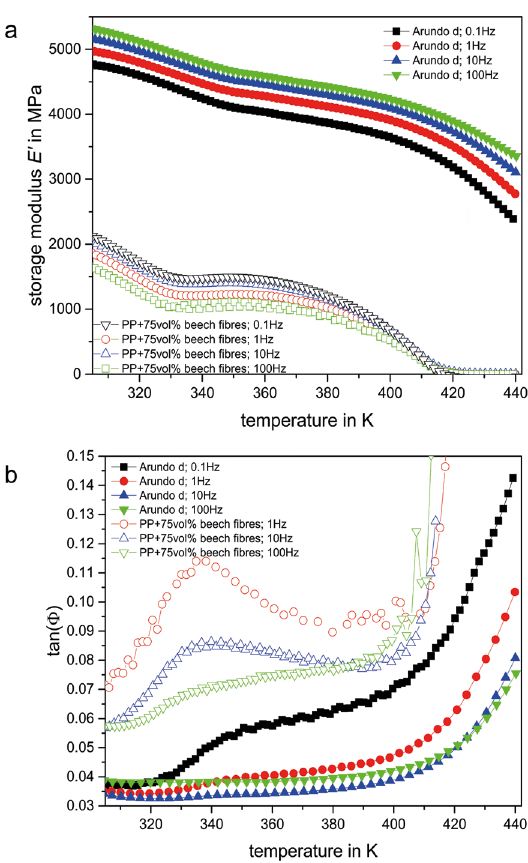
Figure 2. Temperature dependent storage modulus (a) and loss factor (b) of Arundo donax and PP-beech fiber composite.